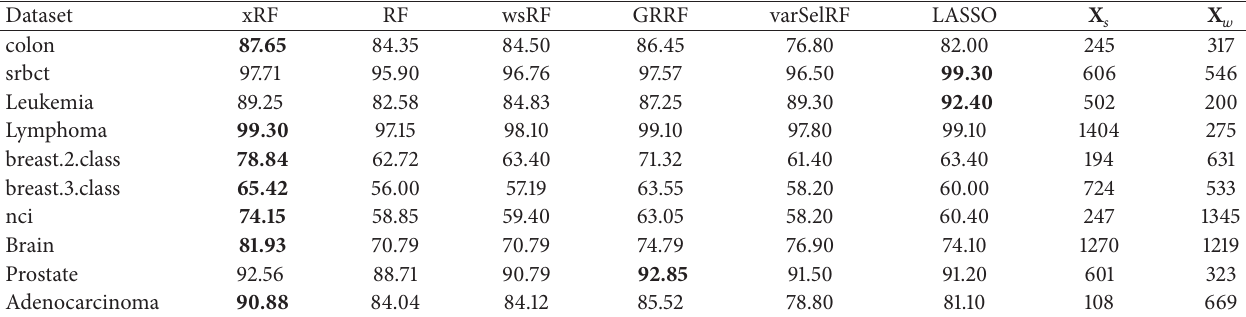
Table 5: Test accuracy results (%) of random forest models, GRRF(0.1), varSelRF, and LASSO logistic regression, applied to gene datasets. The average results of 100 repetitions were computed; higher values are better. The number of genes in the strong group X 𝑠 and the weak group X 𝑤 is used in